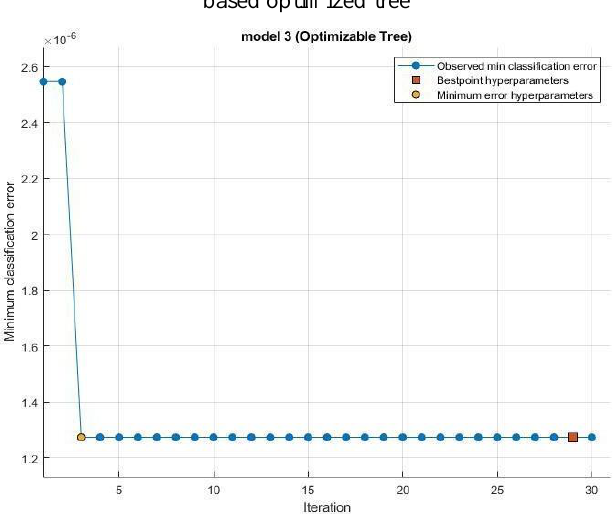
Fig. 13. Fuzzing minimum classification error of grid search based optimized tree